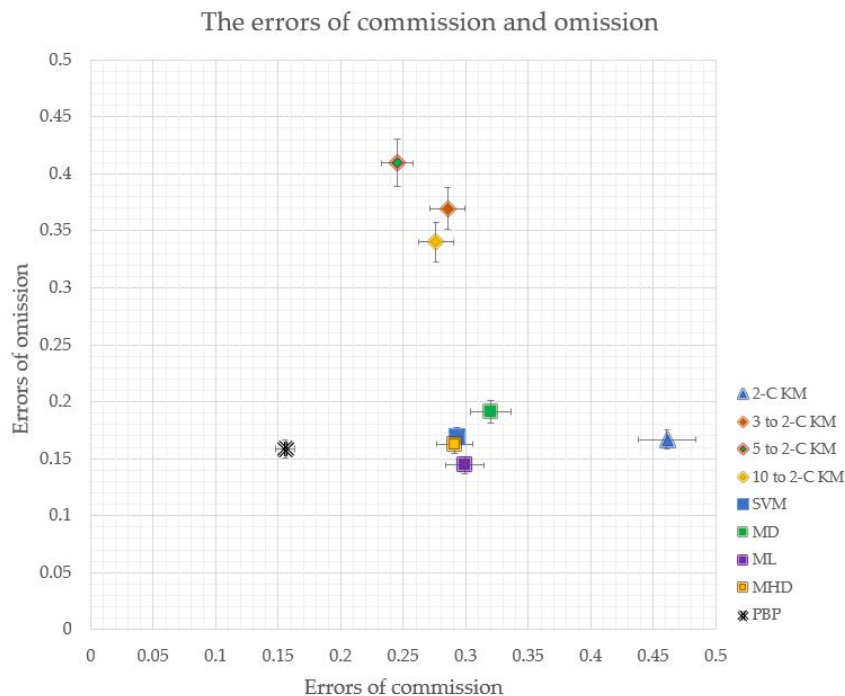
Figure 11. Comparison of the errors of commission and omission among classifiers.